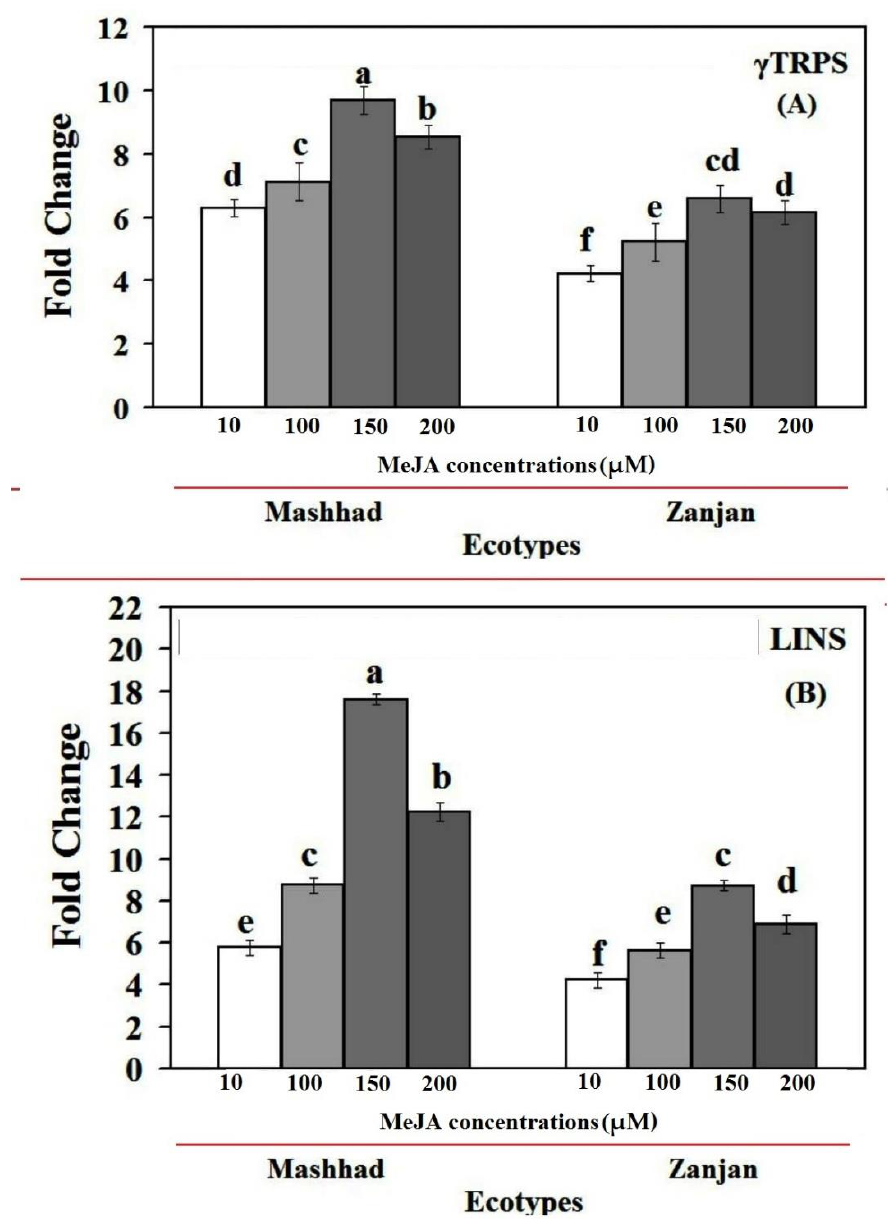
Figure 4. Linalool biosynthetic pathway genes Cs γ TRPS ( A ) and CsLINS ( B ) are expressed in the leaves of control (untreated) and MeJA-treated coriander plants, respectively. The Ct values formed the basis of qRT-PCR. The reference gene actin was used to standardize the Ct value for each sample. According to Duncan’s test, bars with different letters are substantially ( p ≤ 0.01) different. Standard error values are shown by error bars.